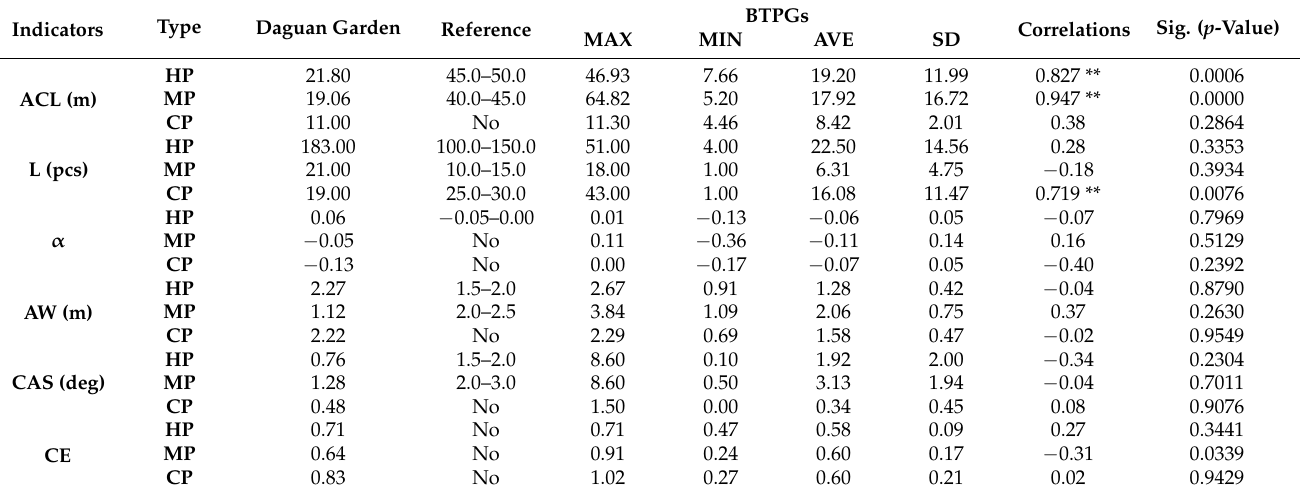
Table 6. Reference range of Daguan